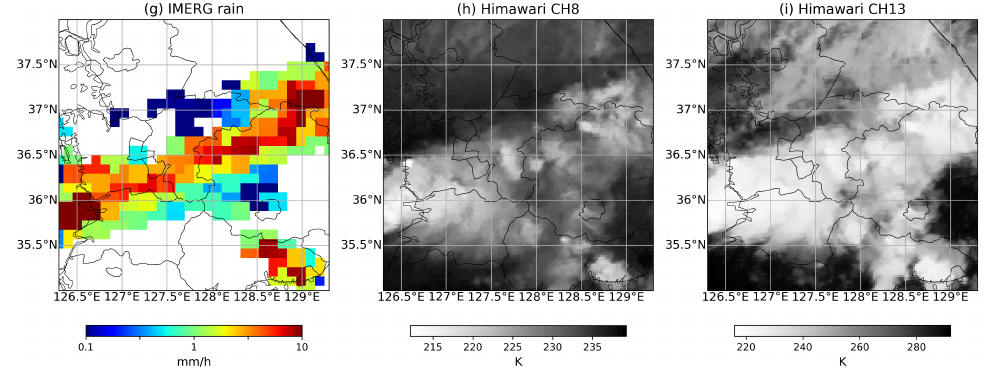
Figure 3. The RAIN-F+ dataset examples of nine variables at 12 UTC on 30 August 2018.